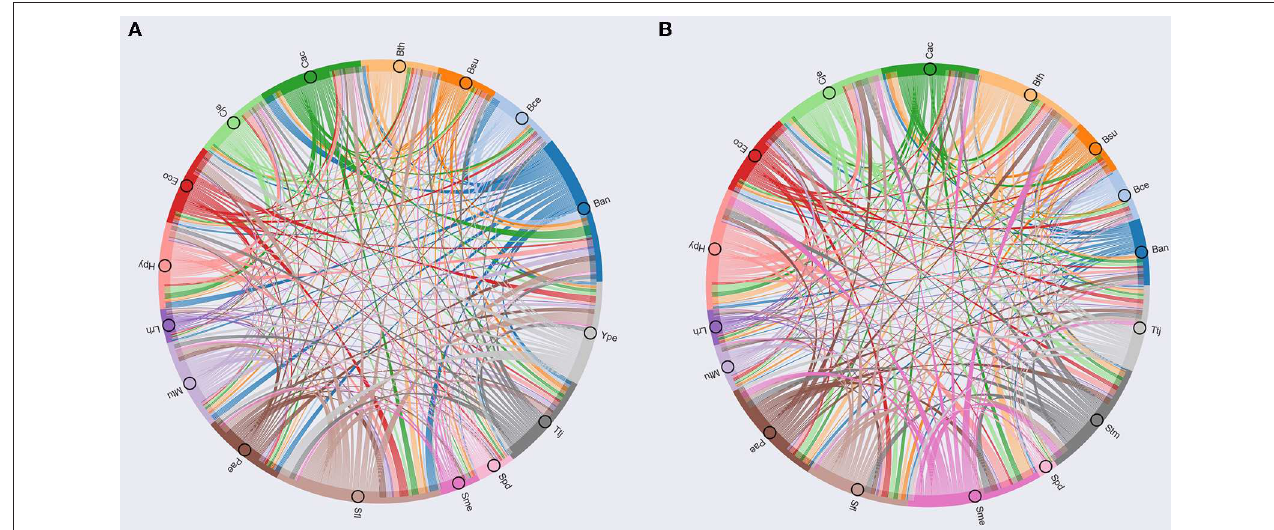
FIGURE 5 | Circos based in Jaccard index. (A) Circos based on TFs; (B) Circos based on metabolic maps.